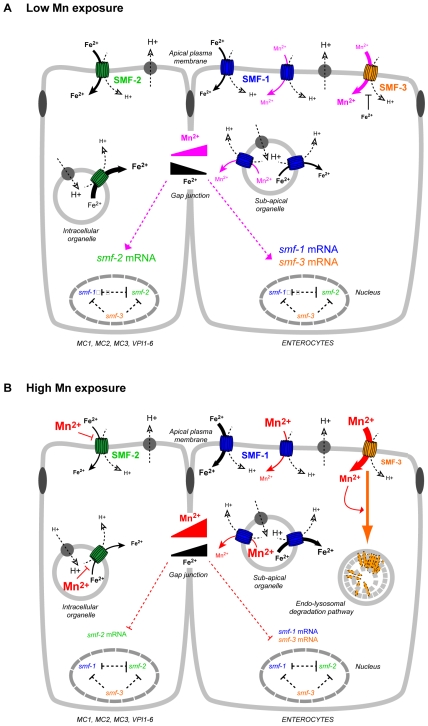
Working model for Mn and Fe uptake by SMF transporters in C. elegans.A: Regulation of Mn, Fe contents and SMF transporters upon low Mn exposure (0.001 mM to 3 mM), which is believed to be beneficial for the worm physiology [92]. B: Regulation of Mn, Fe contents and SMF transporters upon high Mn exposure (50 mM to 150 mM), which was shown to be toxic (Fig. 3, 4). We propose that SMF-3* is the main transporter responsible for Mn uptake (A), and that it is degraded upon exposure to high Mn concentrations (B). Since high Fe content limit Mn uptake, SMF-3 may be inhibited by intracellular Fe (A). SMF-1 would be involved in Mn uptake to a lesser extent, and together with SMF-2*, would be responsible for Fe uptake. Upon Low Mn exposure SMF-2 would be mostly required for Fe uptake (A), whereas upon high Mn exposure, SMF-2 would be inhibited and SMF-1 would partially compensate for Fe uptake (B). In the case of SMF-2 and SMF-1, metal uptake could essentially take place in acidified endosomal compartments, as SMF-2 is mainly cytoplasmic and SMF-1 is detected in sub-apical compartments. Gap-junction communications between pharyngeal epithelia, vpi cells and intestinal cells permit Mn2+ and Fe2+ to diffuse distant from their site of uptake, allowing metal-dependent regulation of smf mRNA stability or transcription. A prediction of our model is that the Fe gradient established by SMF-2 activity would be reversed upon high Mn exposure (B), and could constitute the signal for smf expression regulation. Since basal smf mRNA levels depend on the integrity of each smf genomic sequence (Fig. 9), transcriptions of smf genes are assumed to be interdependent, maybe because they require a common transcription factor. * SMF-2 might transport Mn and SMF-3 might transport Fe, but these possibilities are not explored in this model. The size of the text reflects the concentration of the species.